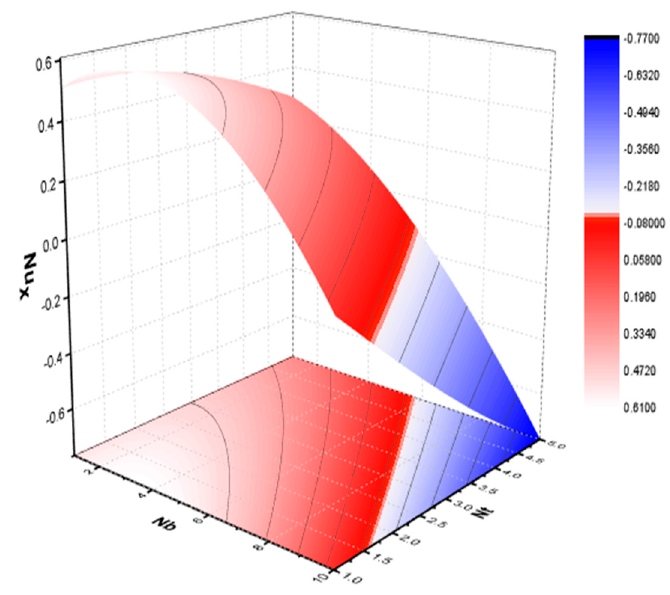
Nu for Nb and Nt . Figure 24. 3D visual of Nu x for Nb and Nt. Figure 24. 3D visual of x Figure 24. 3D visual of x